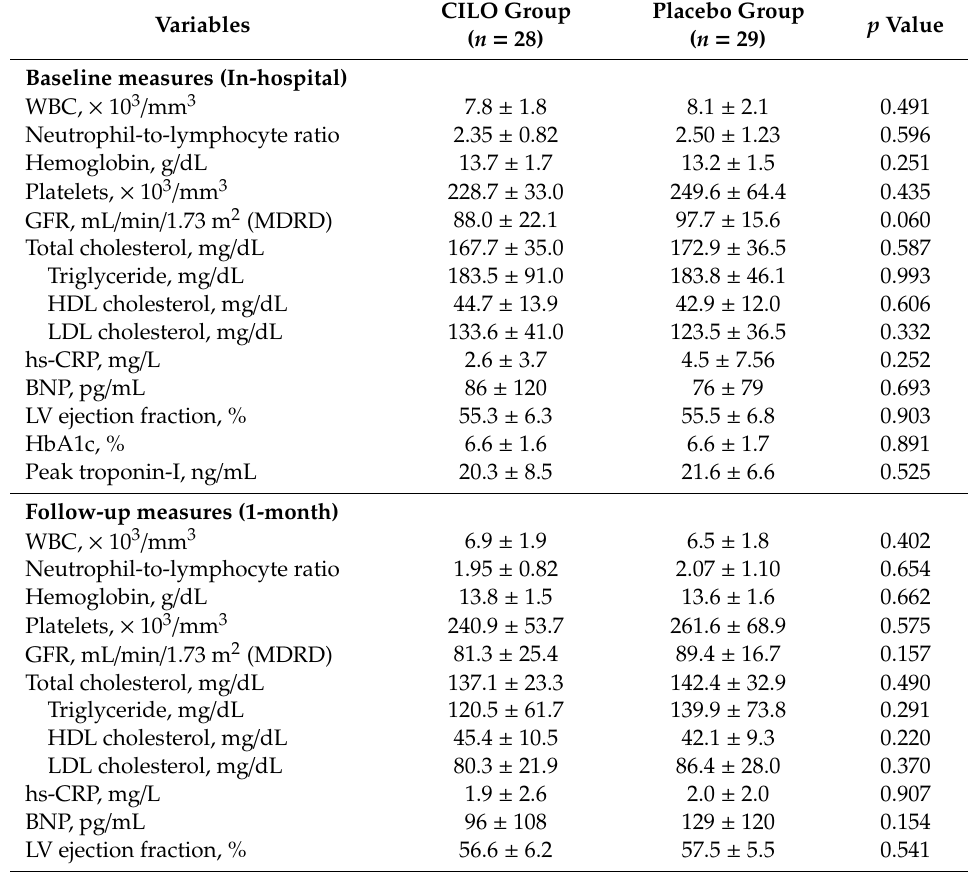
Table 2. Laboratory